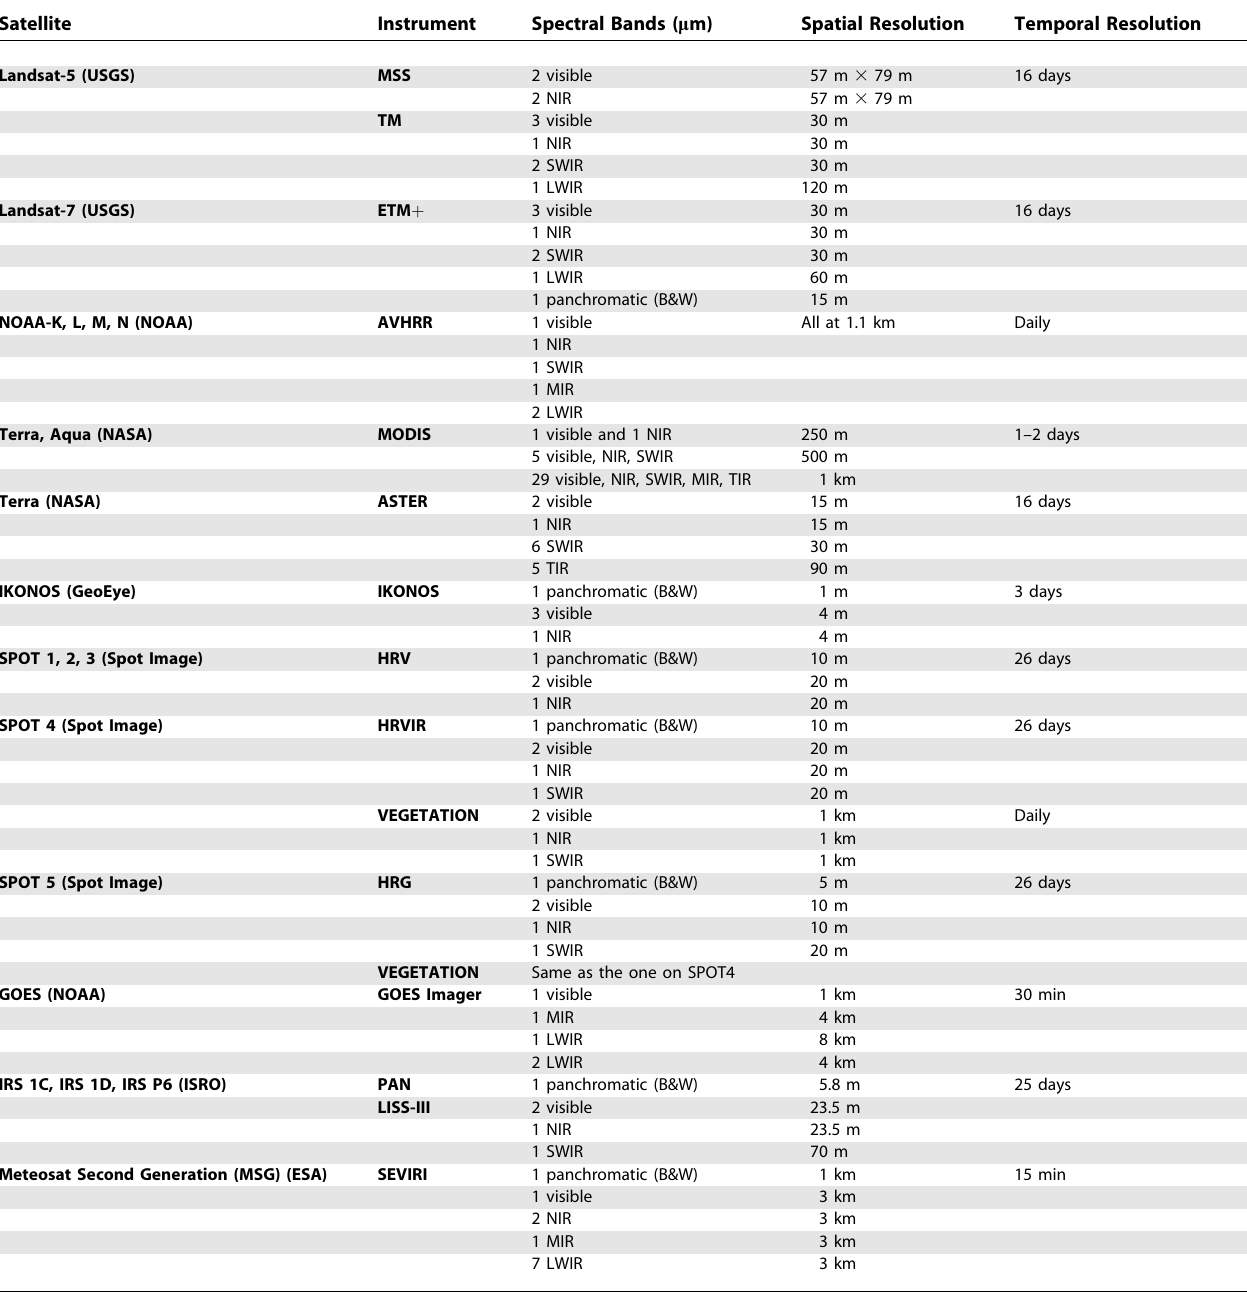
Table 3. Characteristics of Different Earth-Observing Satellite Instruments Discussed in This Paper That Have Potential Applications in Epidemiology